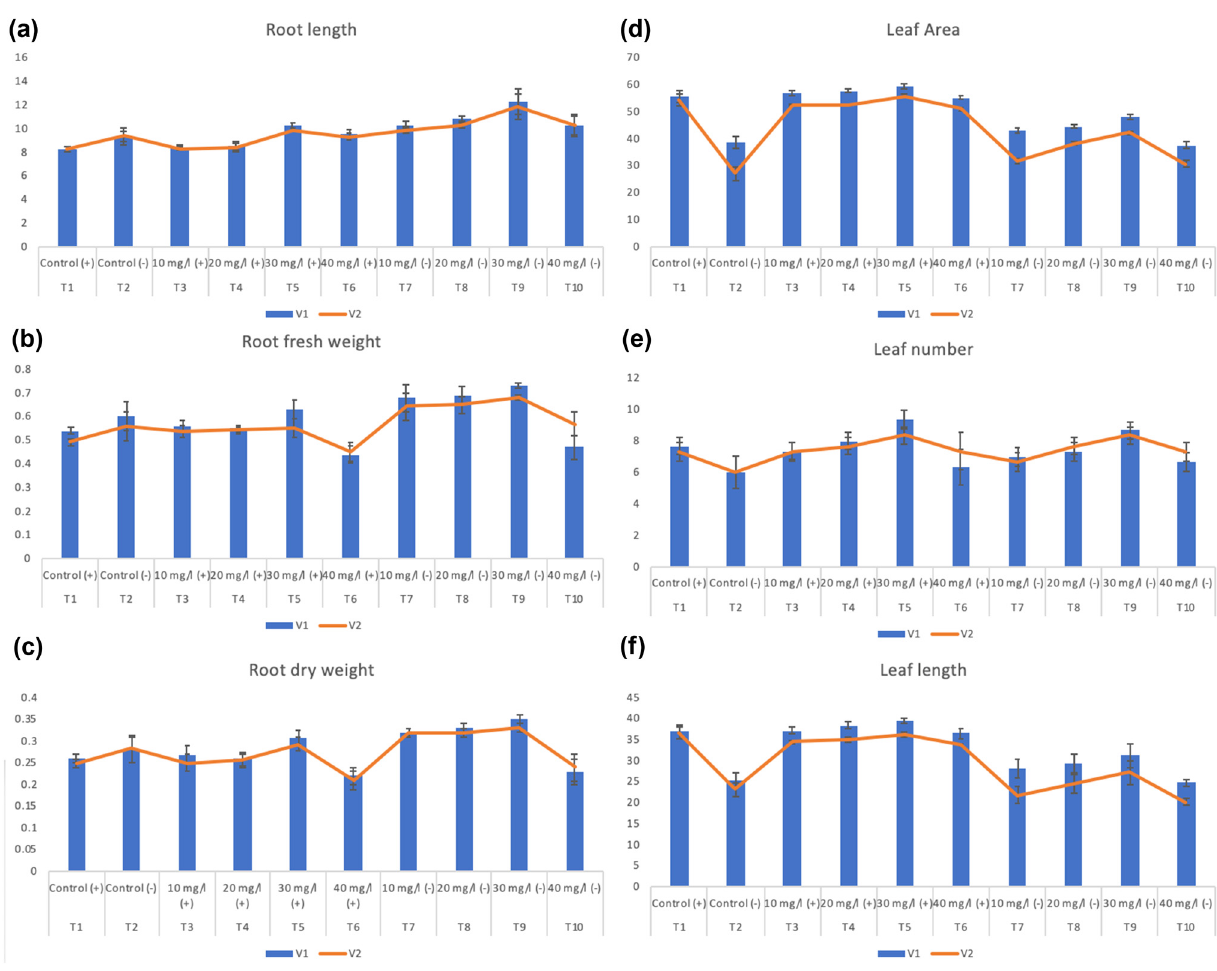
Figure 5: E ff ect of di ff erent treatments of SeNPs on ( a ) root length, ( b ) root fresh weight, ( c ) root dry weight, ( d ) leaf area ( e ) , leaf number, and ( f ) leaf